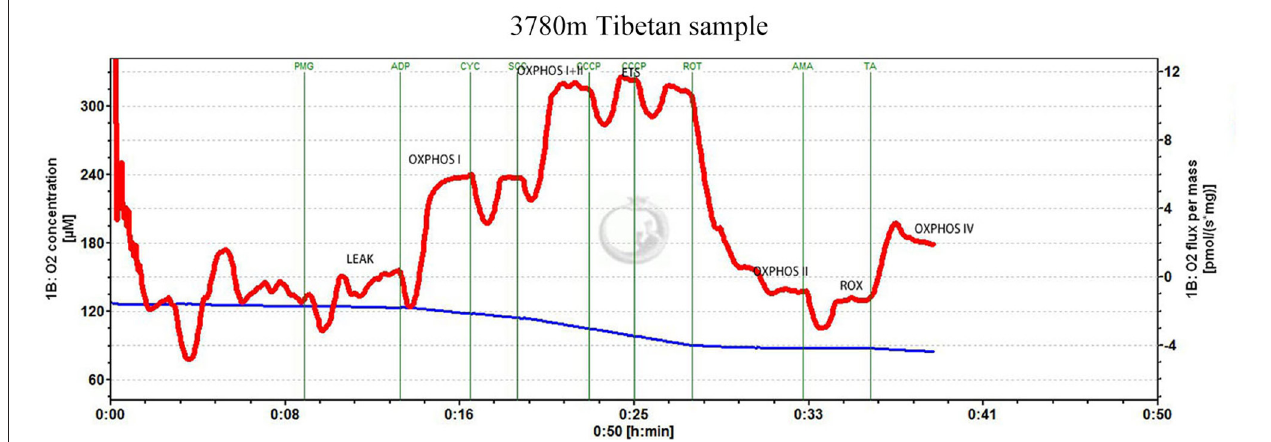
FIGURE 1 | Substrate-uncoupler-inhibitor titration (SUIT) protocol. Representative oxygraph traces of oxygen flux relative to tissue mass. The vertical lines show the introduction of various substrates or inhibitors. LEAK refers to non-phosphorylating respiration; OXPHOS CI, CII, and CIV represent oxidative phosphorylation through mitochondrial complexes I, II, and IV, respectively; ETS max represents electron transfer system maximum capacity; ROX represents non-ETS respiration; PMG represents pyruvate, glutamate, and malate; CYC represents cytochrome c; ROT represents rotenone; SCC represents succinate; CCCP represents the